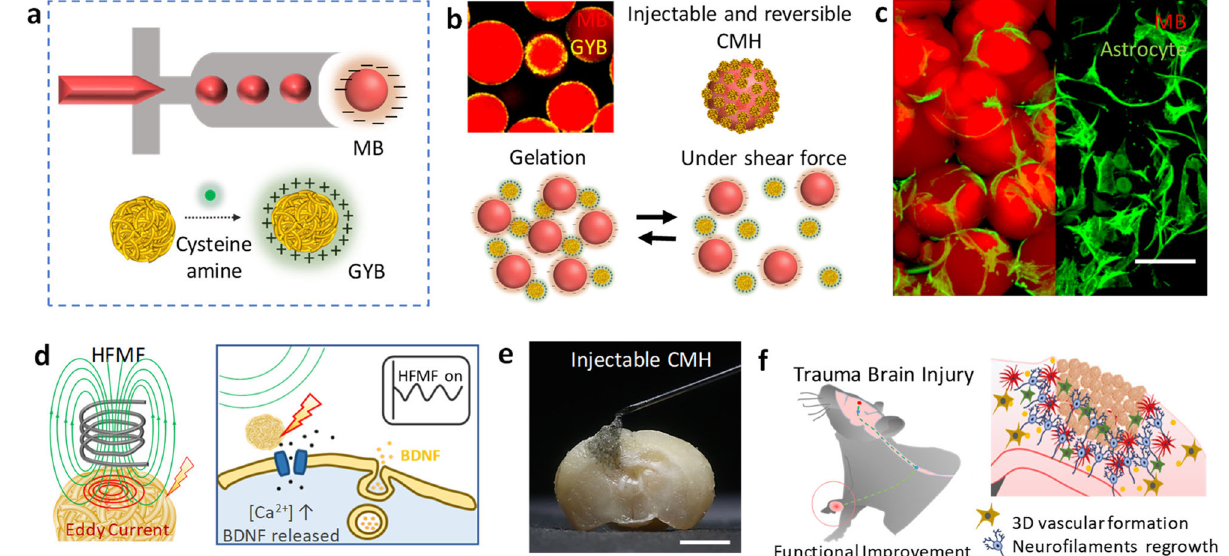
Fig. 1 | Formation of an adaptable conductive microporous hydrogel (CMH). a Schematic illustration of monodispersed gelatin methacrylamide (GelMA) injectable building blocks (microbeads, MBs) formation (upper); the process of synthesizing cys-GYB (lower). b Schematic illustration of injectable and reversible CMH. c Fluorescence image of a cell-laden micronetwork scaffold. Scale bar: